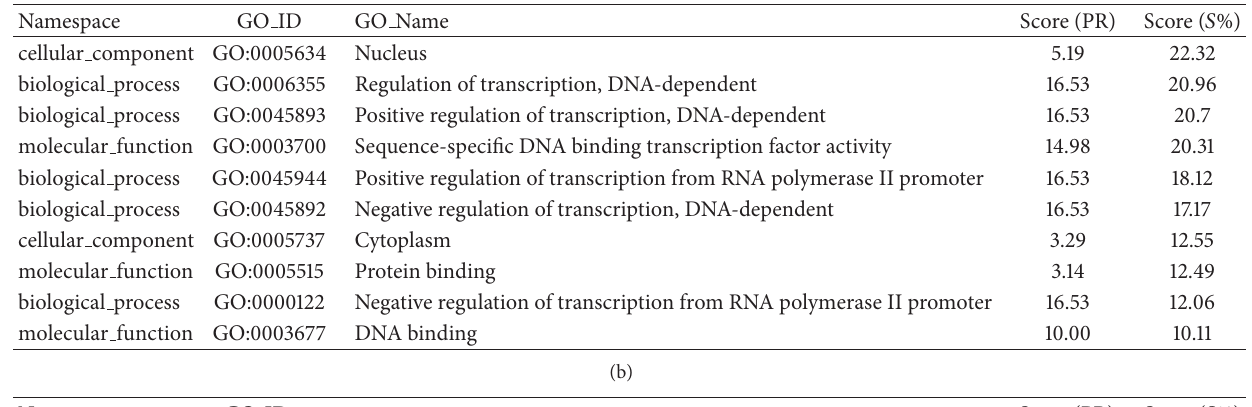
Table 1: (a) Top 10 terms in the GOLink all list generated using the query term “regulation of gene expression” (GO:0010468) and applying the evidence code filter “!IEA” and database filter “UniProtKB.” (b) Top 10 terms in the GOLink query list generated using the query term “regulation of gene expression” (GO:0010468) and applying the evidence code filter “!IEA” and database filter “UniProtKB.” (c) Top 10 terms in the GOLink parchild list generated using the query term “regulation of gene expression” (GO:0010468) and applying the evidence code filter “!IEA” and database filter